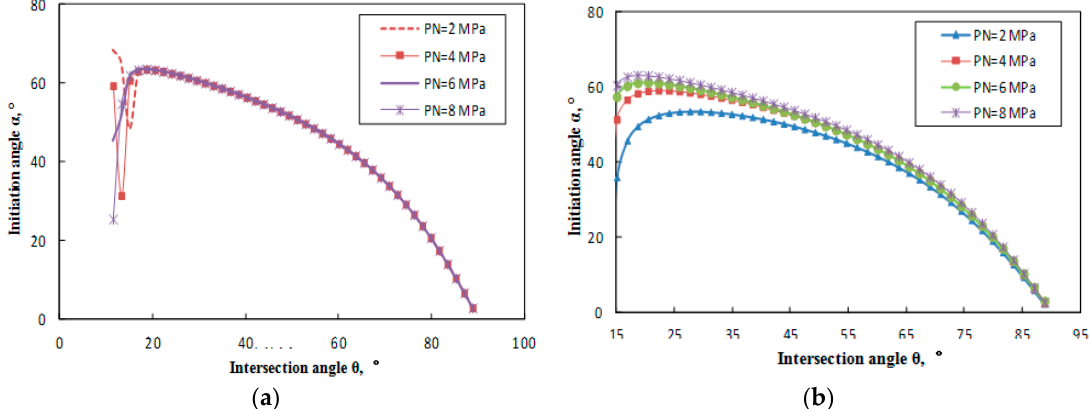
Figure 11. The impacts of net pressure on the initiation angle for (a) multiple fractures, and (b) a single